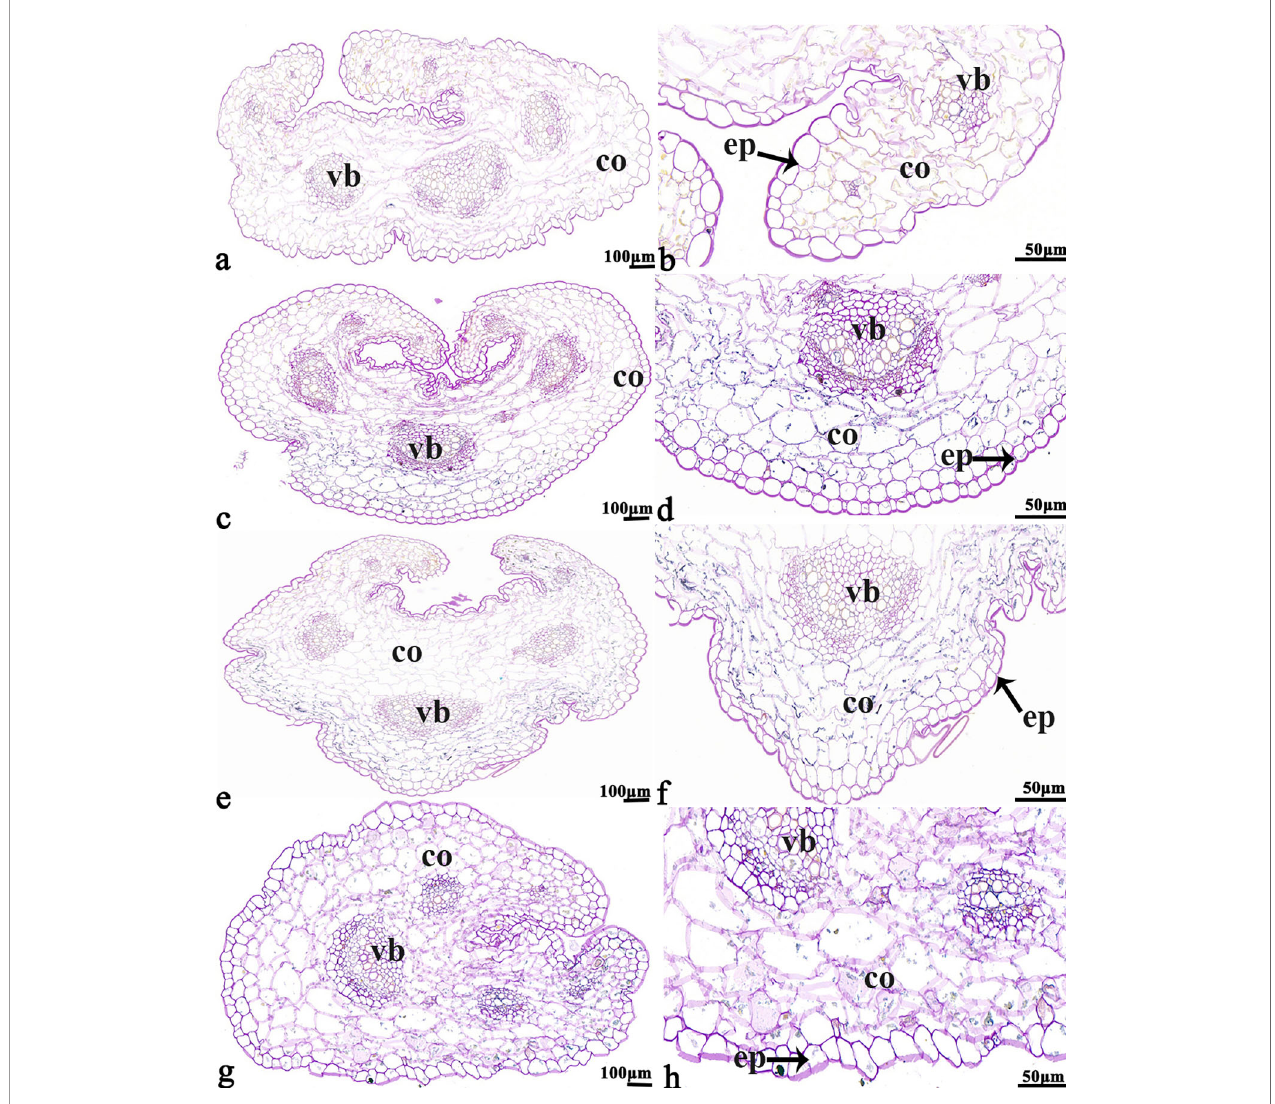
FIGURE 6 | B. napus cultivars 16NTS309 and Tianyou2238 under non-cold (A, B, E, F) and cold stress (C, D, G, H) conditions for 48 h. The deepest stem samples with blue formazan precipitate areas in 16NTS309 (A – D) and Tianyou2238 (E – H) were sectioned for morphoanatomical analysis. vb, vascular bundle; co, cortex; ep, epidermis. Scale bars = 50 µm and 100